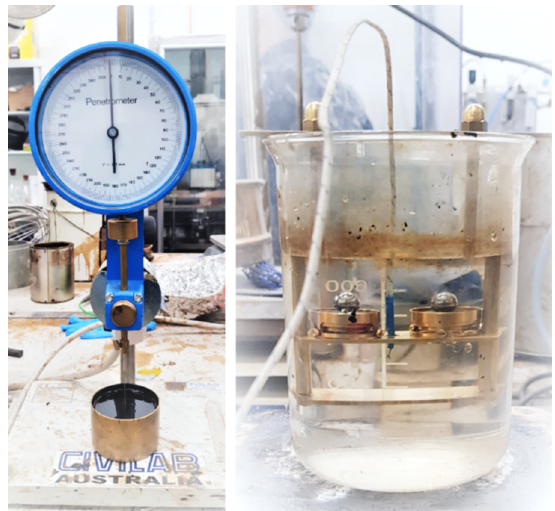
Figure 8. Penetration test (on left) and softening point test (on right) of a sample carried out in this study.